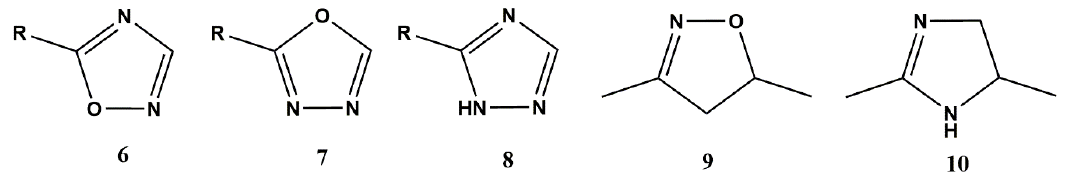
Figure 8. Examples of heterocyclic rings as replacements for amide and ester groups. The 1,2,3-oxadiazoles (6), 1,3,4-oxadiazoles (7), triazoles such as 1,2,4-triazoles (8), 2-isoxazoline (9), and imidazoline entities (10).